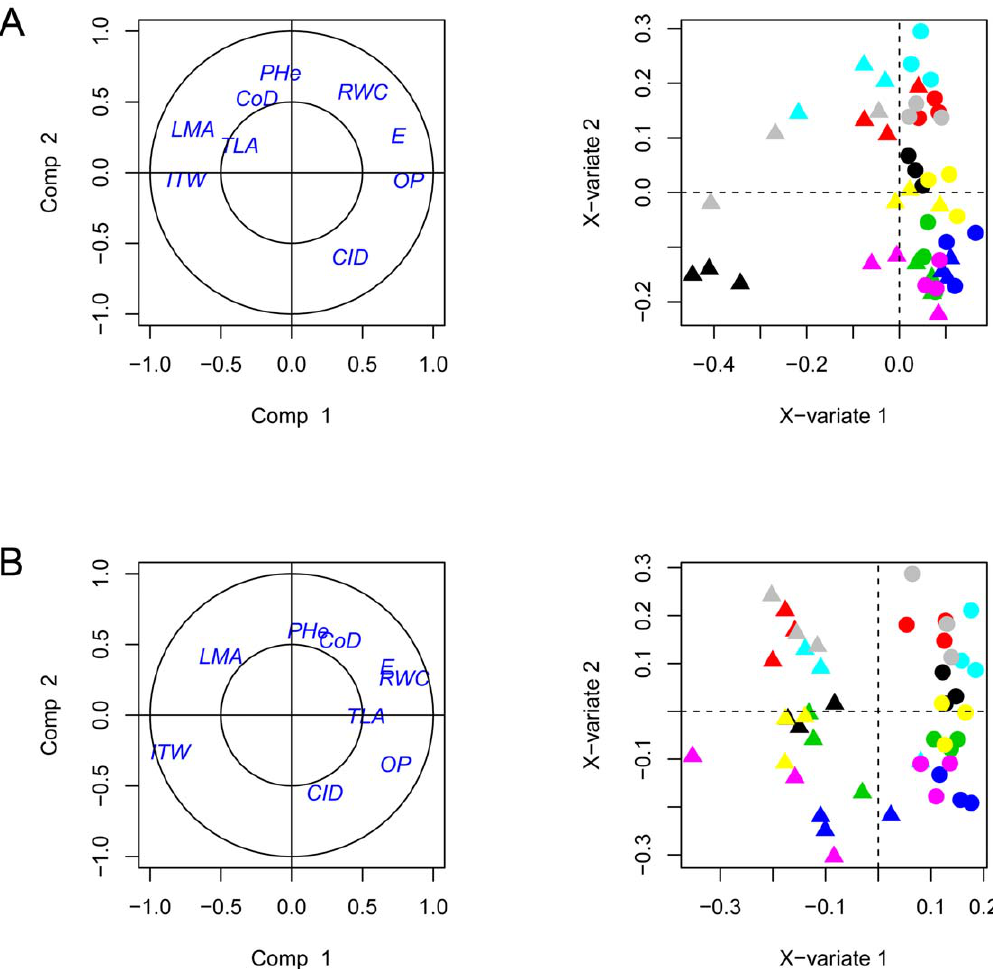
Figure 3. Results of the sparse Partial Least Squares (SPLS) analysis on plants under FDS (A) and FIS (B). Plots show respectively the repartition of the morphophysiological variables (left) and individuals (right) along the first two components of the SPLS. Morphophysiological variables are carbon isotope discrimination (CID), collar diameter (CoD), Transpiration rate (E), Integrated Transpired Water (ITW), Leaf Mass per Area (LMA), Osmotic Potential (OP), Plant Height (PHe), Relative Water Content (RWC) and Total plant Leaf Area (TLA). Triangles correspond to treated plants whereas circles correspond to their untreated counterparts. Genotypes are color-coded as follows: Inedi (black), Tekny (gray), Melody (red), SF109 (turquoise), SF326 (yellow), SF193 (magenta), SF028 (green) and SF107